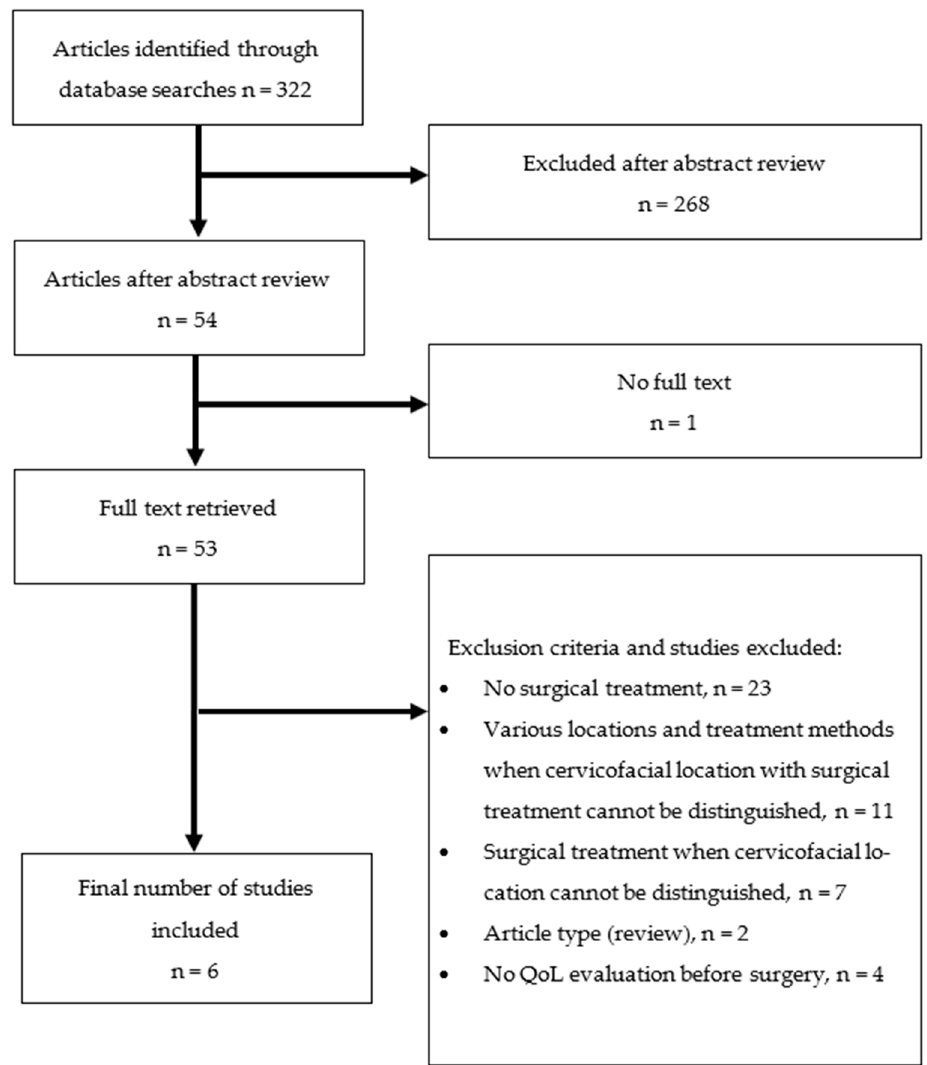
Figure 1. Article selection flow diagram.